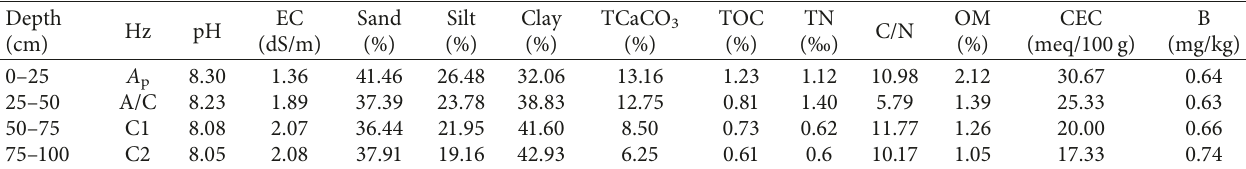
Table 1: Selected physicochemical properties of the studied soil.